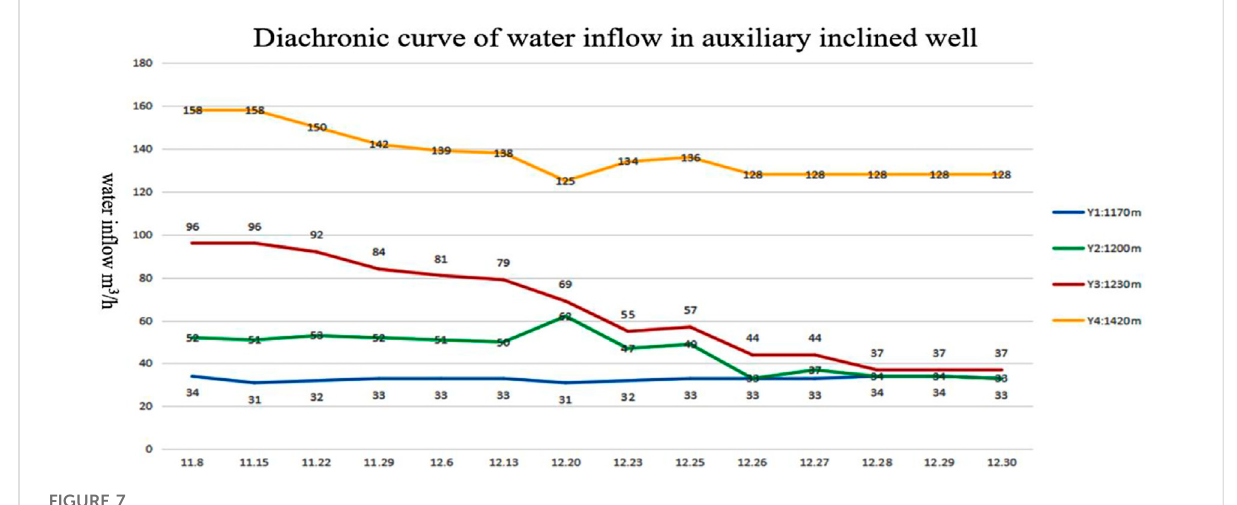
FIGURE 7 Trends of reduction in the water yield after